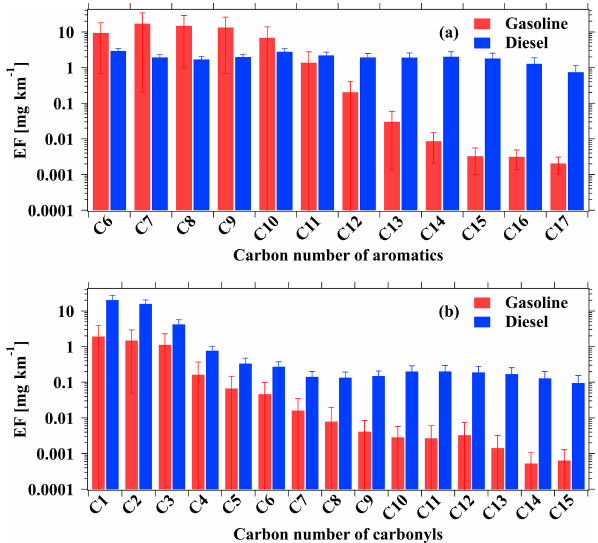
Figure 9. The determined emission factors of (a) aromatics and (b) carbonyls for each carbon number from gasoline and diesel ve- hicles. Error bars represent standard deviations of the emission fac- tors for the VOCs of different carbon